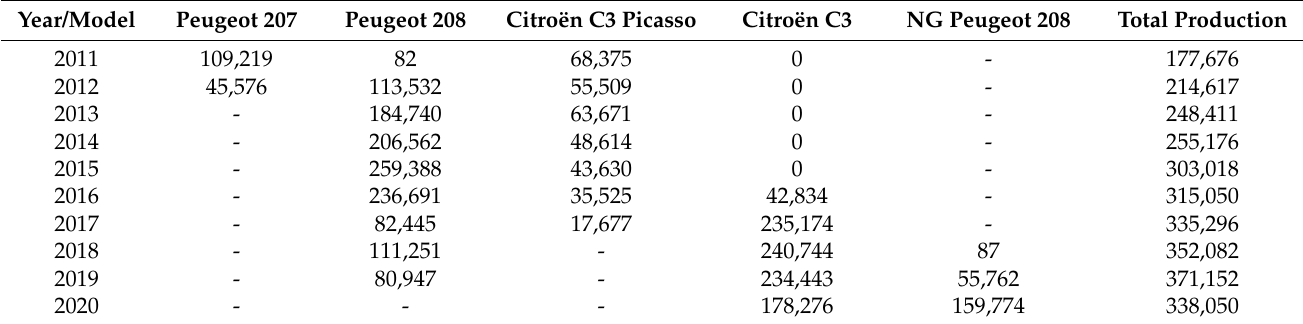
Table 6. Production of cars in PSA Group SVK (10 years).